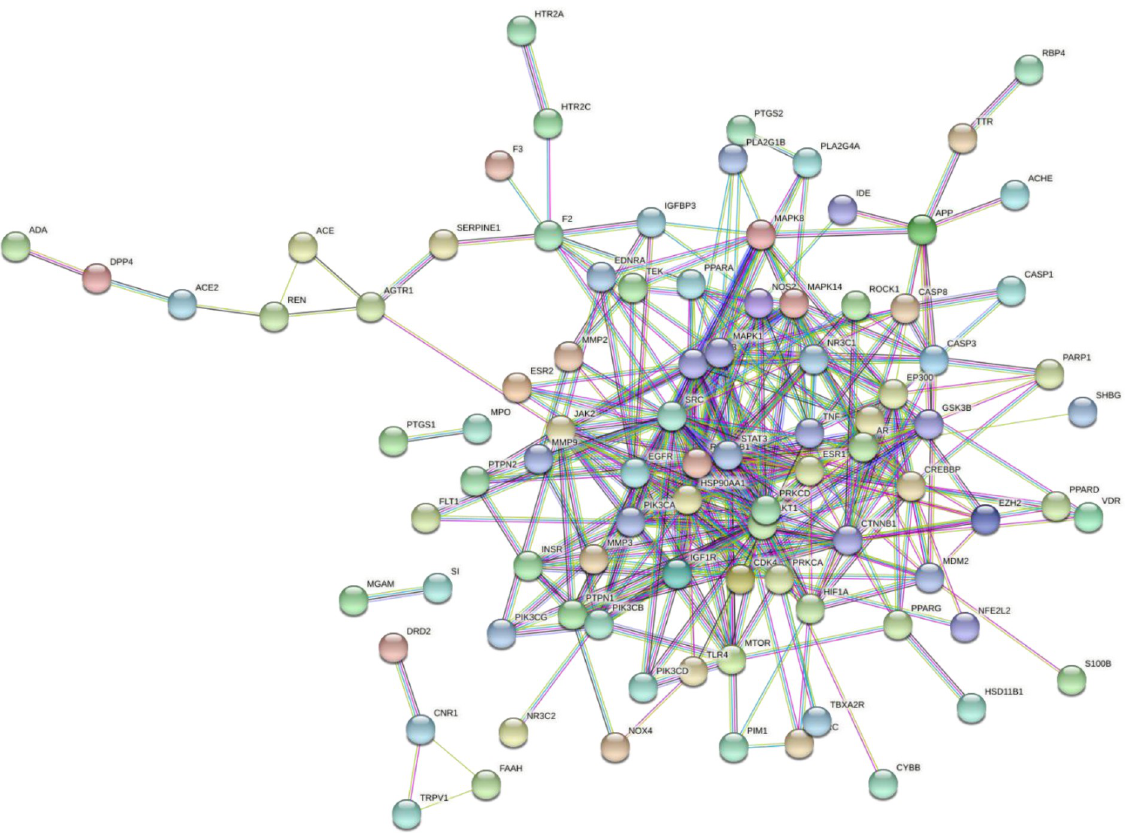
Fig 5. PPI network of target and disease-related genes constructed using STRING